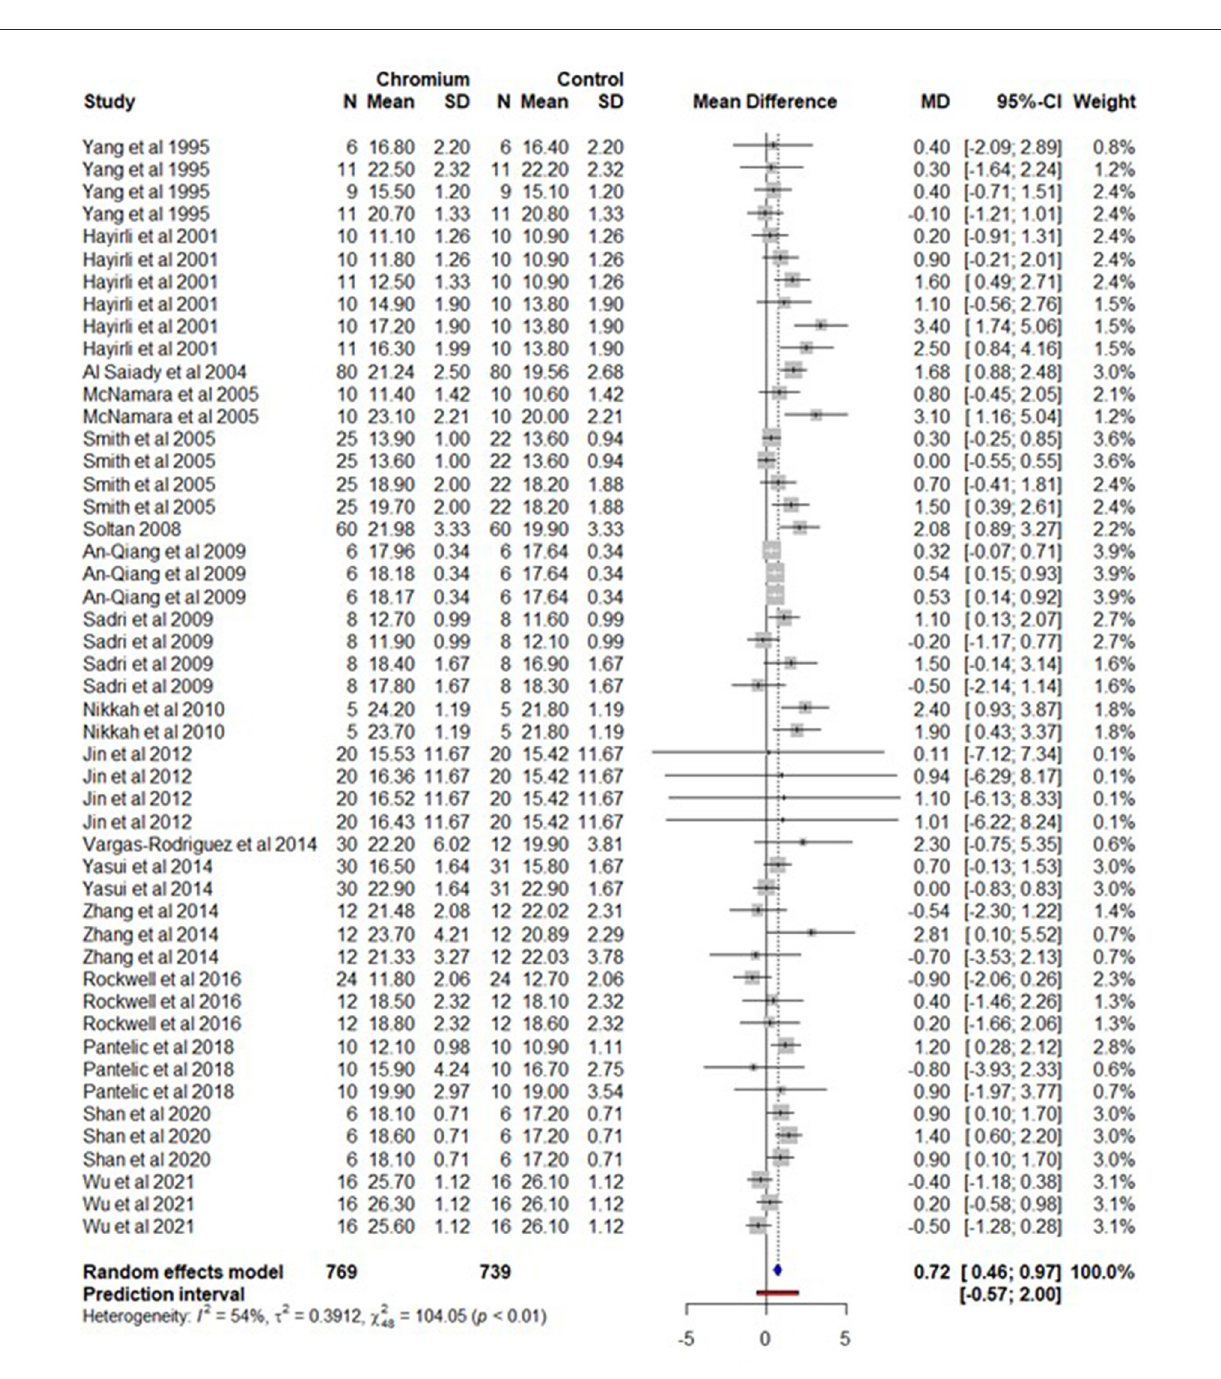
FIGURE2 The forest plot of the random-effect meta-analysis for dry matter intake. The effect size was calculated as the mean difference (MD), and the solid vertical line represents the line of no effect or zero line. The dotted vertical line represents the average effect size for dry matter intake in cows supplemented with chromium. The negative value under the MD heading indicates a decrease in dry matter intake and vice versa. The black horizontal line represents the confidence interval for each study and the gray square represents weight or effect size of the corresponding study. The blue diamond represents the average effect size of the